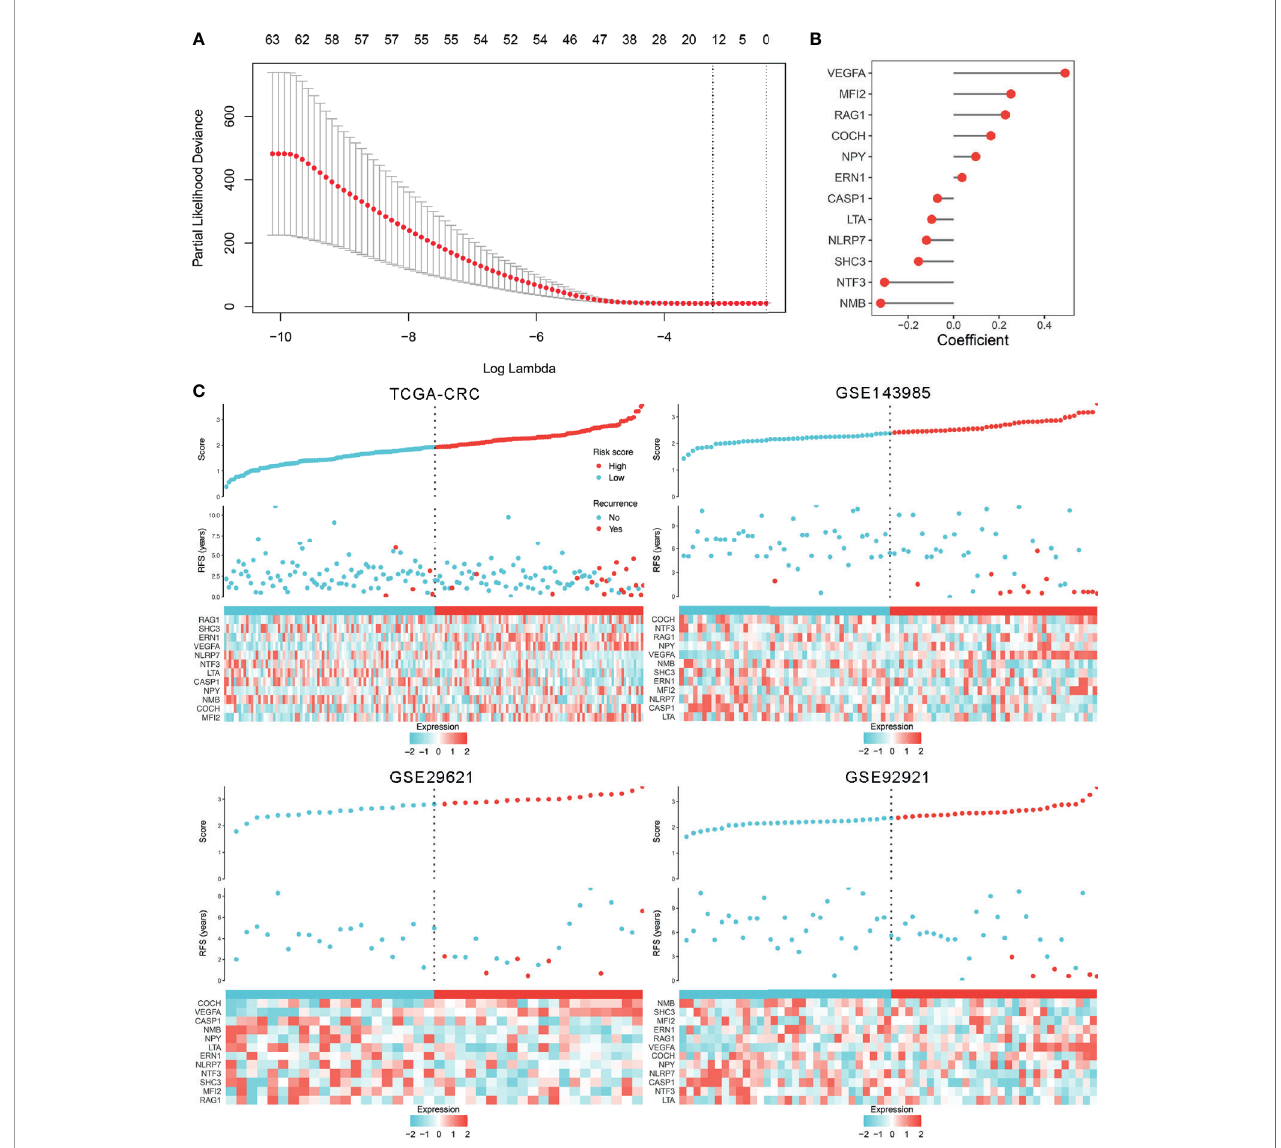
FIGURE 2 | The development of the RAIS model based on the LASSO algorithm. (A) Ten-fold cross-validations to tune the parameter selection in the LASSO model. The two dotted vertical lines are drawn at the optimal values by minimum criteria (left) and 1 − SE (standard error) criteria (right). (B) LASSO coef fi cient pro fi les of the candidate genes for RAIS construction. (C) The distribution of risk score, recurrence status, and gene expression panel in four